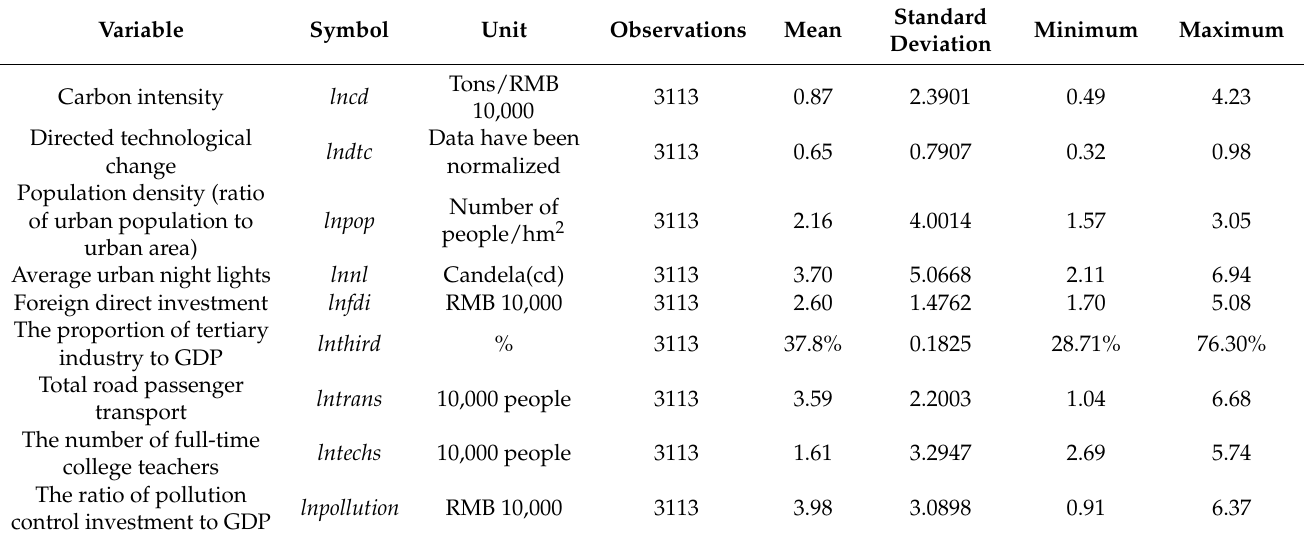
Table 2. Statistical description of main